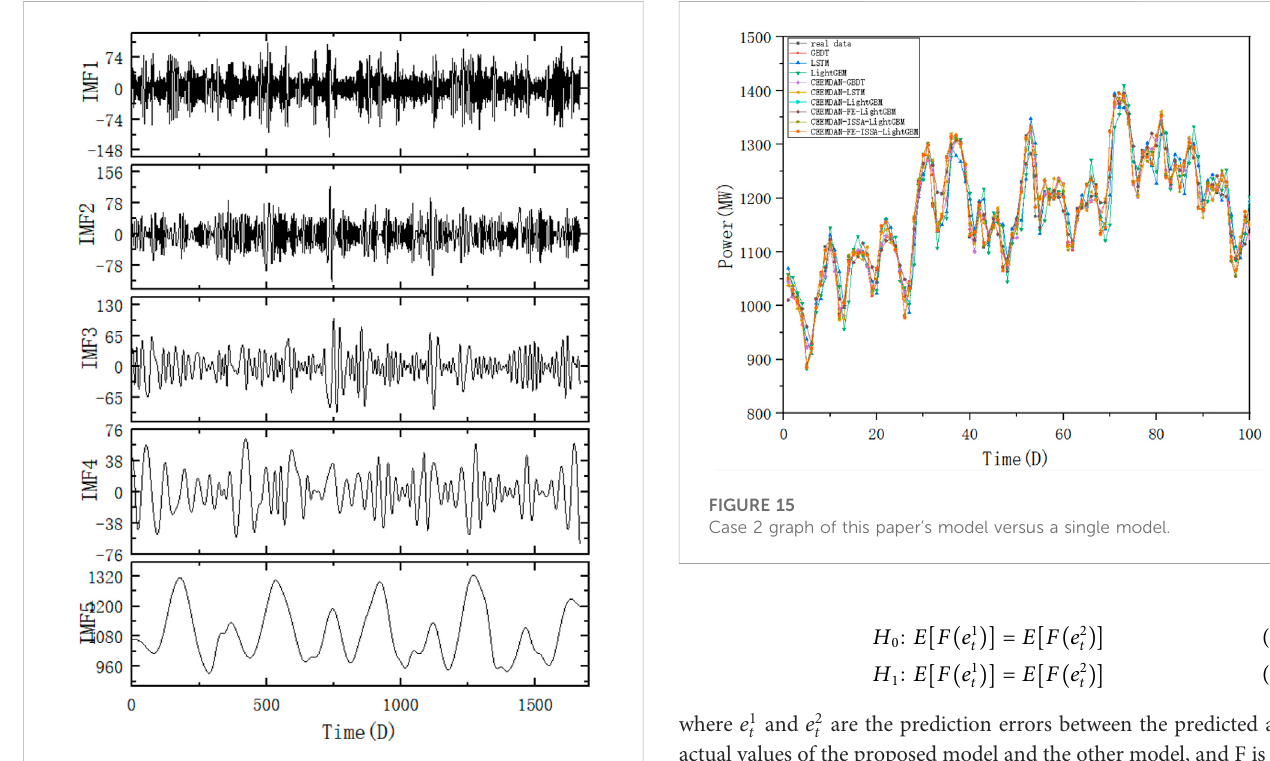
FIGURE 14 CEEMDAN-FE processing results of Case 2.